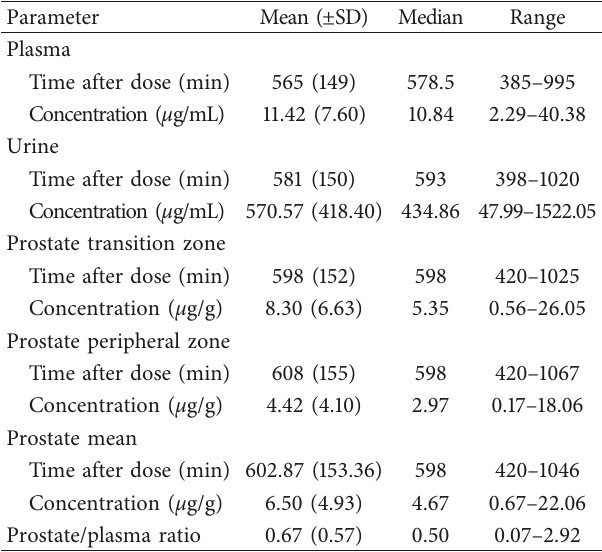
Table 2: Fosfomycin concentrations in plasma, urine, and prostate following a single 3g oral dose a .